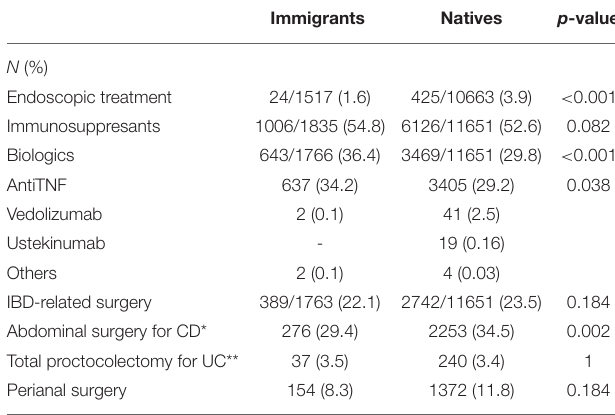
TABLE 3 | Medical treatments and surgical procedures in the immigrant and native-born IBD population in Spain. Immigrants